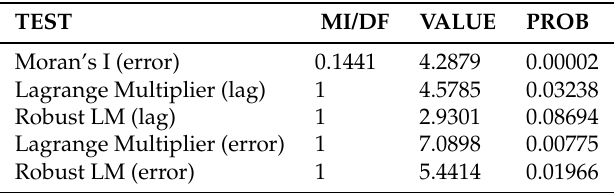
Table 6. Diagnostics for spatial